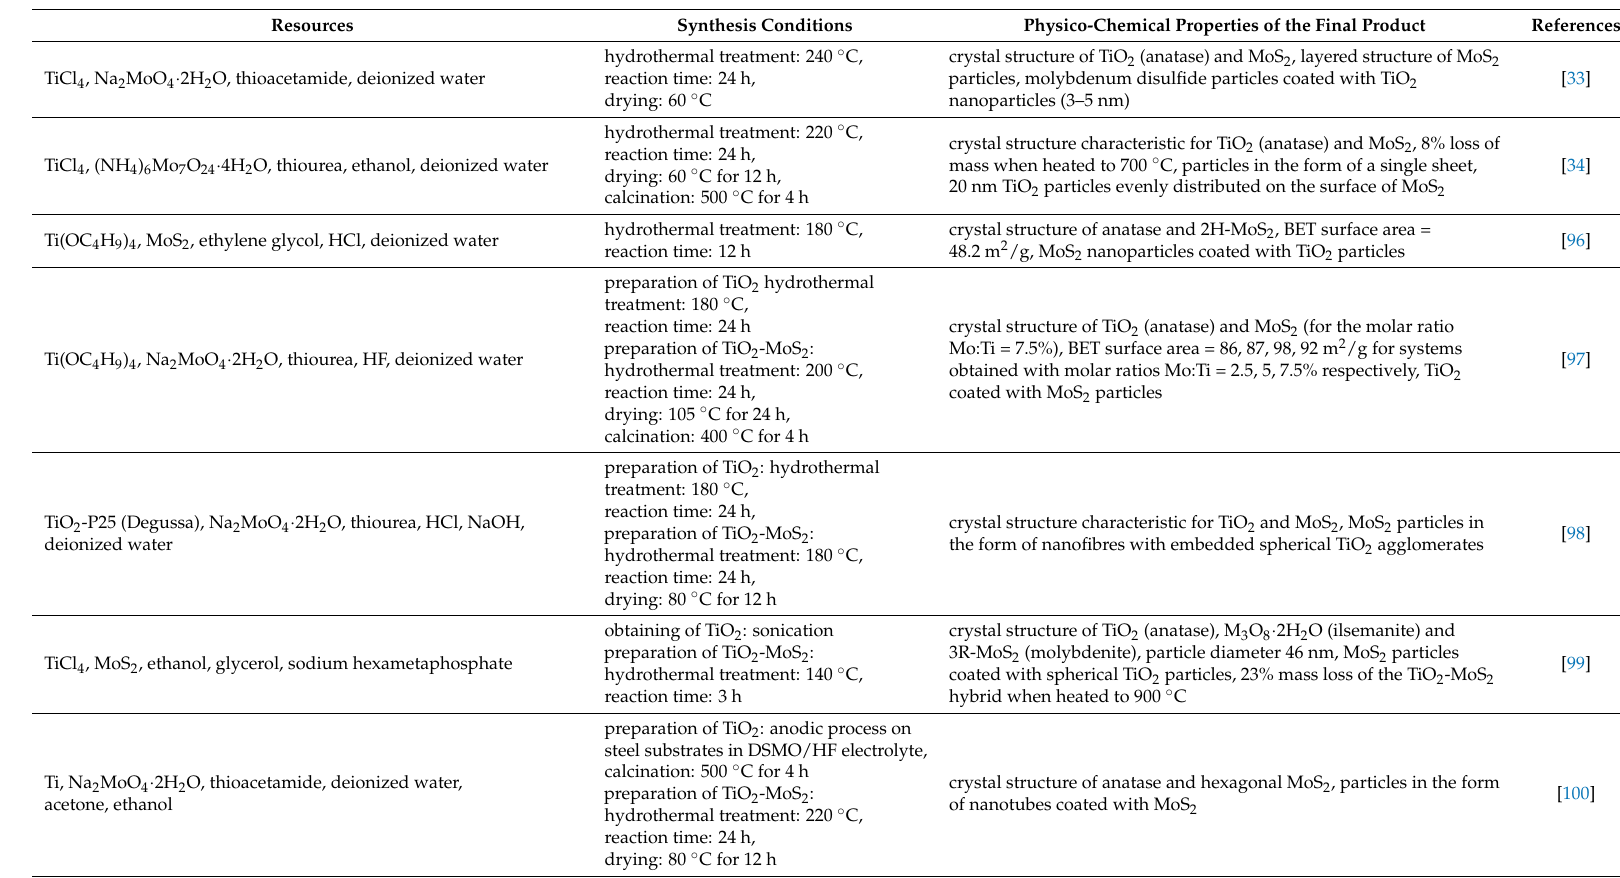
Table 3. Resources, synthesis conditions and physico-chemical properties of TiO 2 -MoS 2 hybrid systems obtained by the hydrothermal